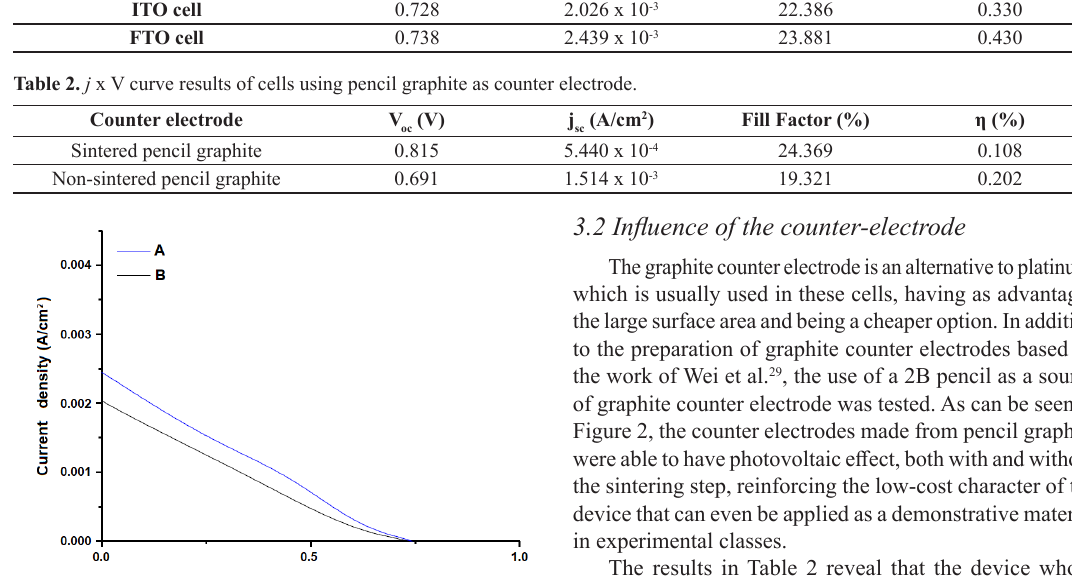
Table 1. j x V curve results of cells with ITO and FTO. Conducting glass